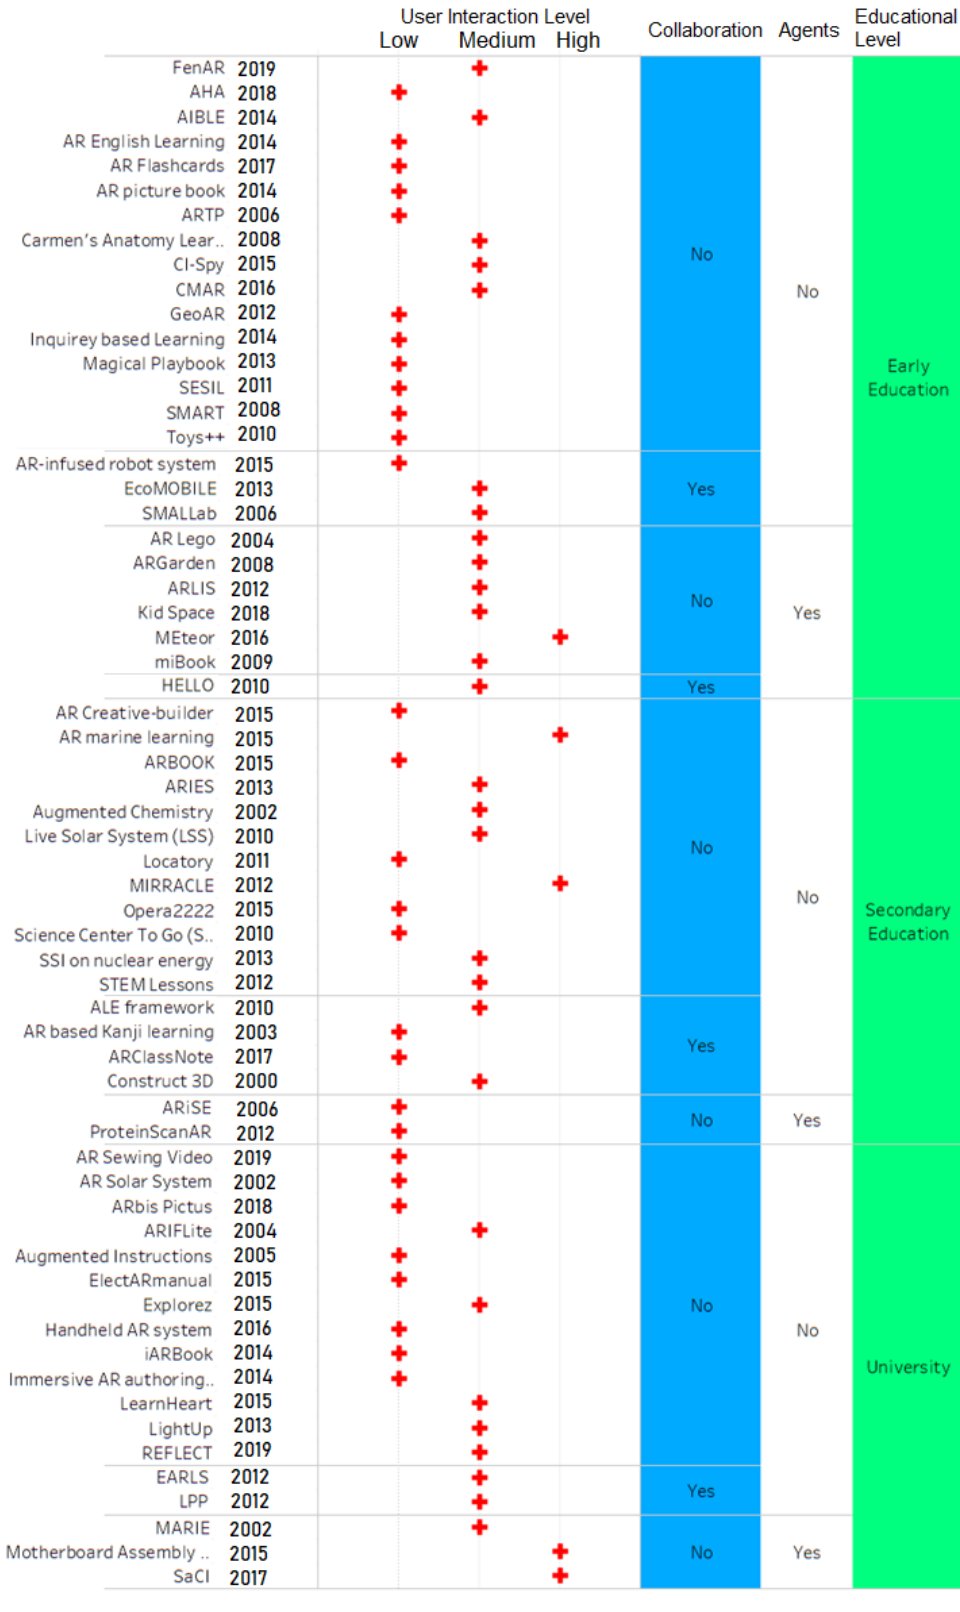
Figure 3. Graphics representation of different AR applications according to their user interaction capacity, collaboration capacity, agents and educational